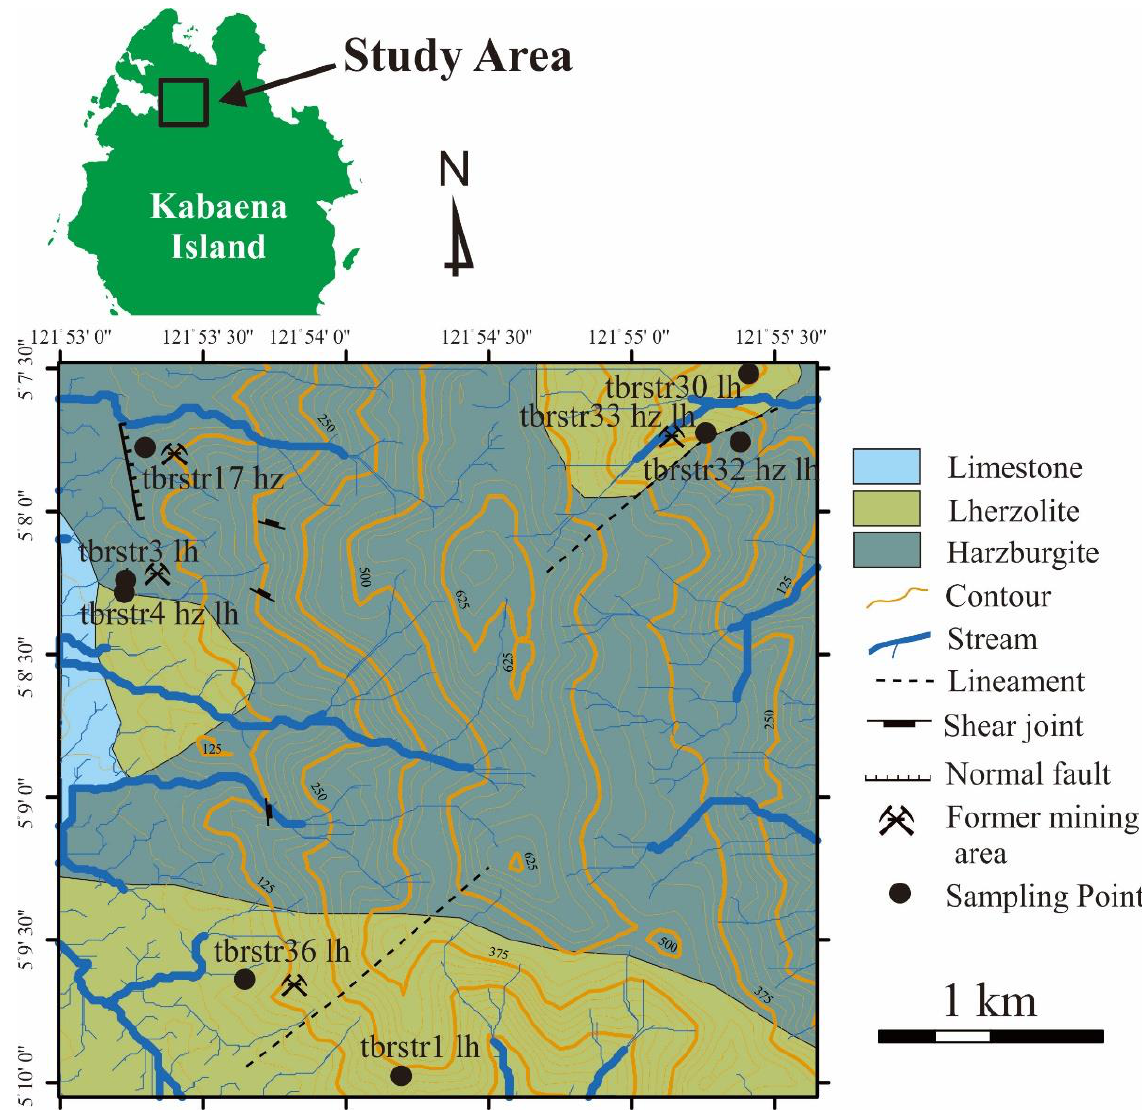
Figure 3. Detailed geological map of the study area (modified after Septiana et al. [32]) and sample location. Geological map of the northern part of Kabaena Island showing the study area (modified after Simandjuntak [34]).